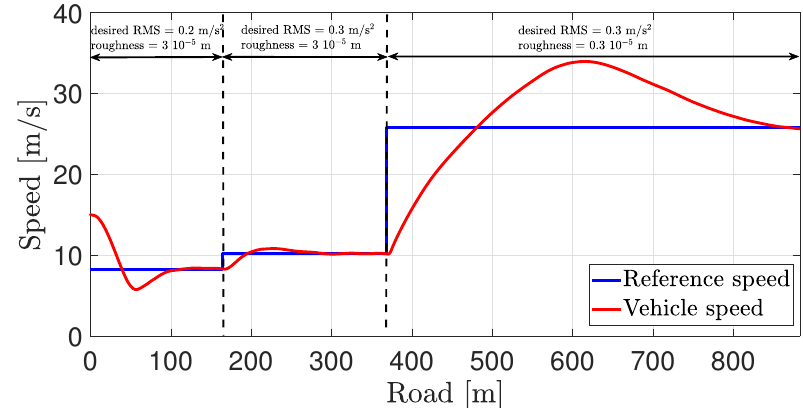
Figure 26. Resulting reference and vehicle speed.